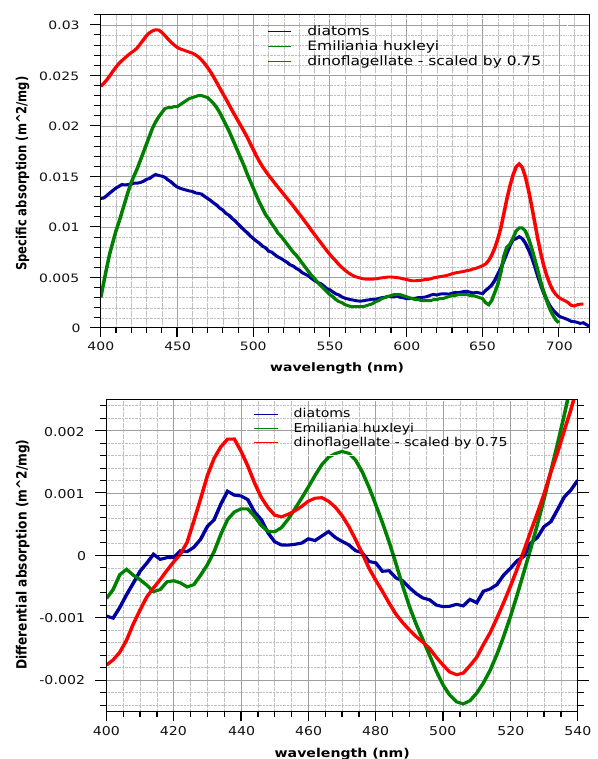
Fig. 1. Upper panel: specific absorption spectra of coccolithophores ( E. huxleyi ) (green), dinoflagellates (red) and diatoms (blue). The first spectrum was obtained from a culture, while the two latter spec- tra were taken from in-situ samples. All spectra were measured using a point-source integrating-cavity absorption meter. Lower panel: differential absorption spectra of three phytoplankton targets. Each of them was derived by subtracting a second-order polynomial from the corresponding specific absorption spectrum, which was shown in upper